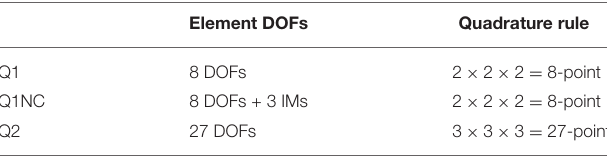
ˆ (cid:127) . Table 1 details the number of DOFs